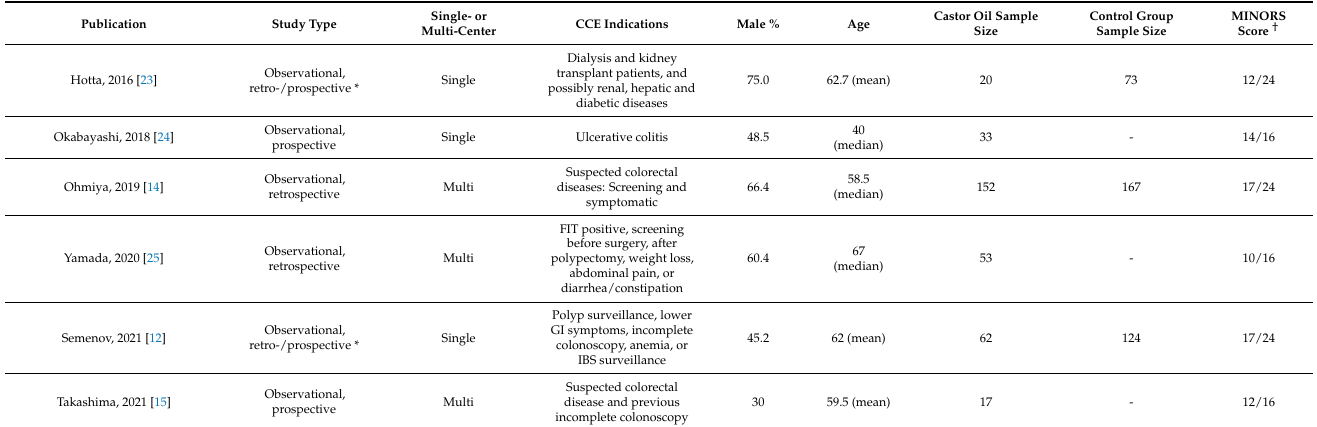
Table 2. Overview of six studies included for meta-analysis colon capsule endoscopy using castor oil in the bowel preparation